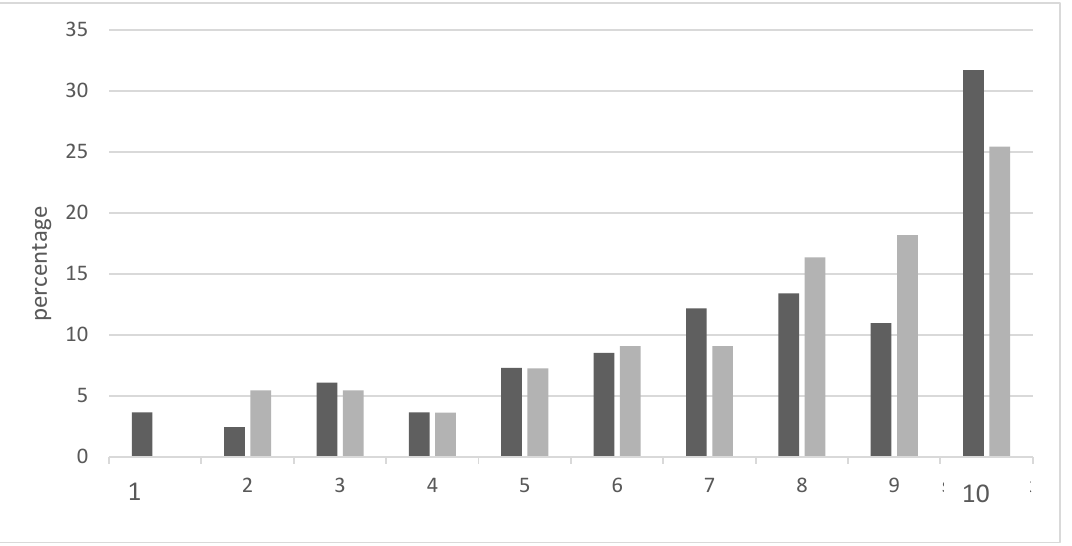
Figure 1. Grade of stress due to infertility. Dark grey bars represent TP2 ( n = 82), the light grey bars TP3 ( n = 55).